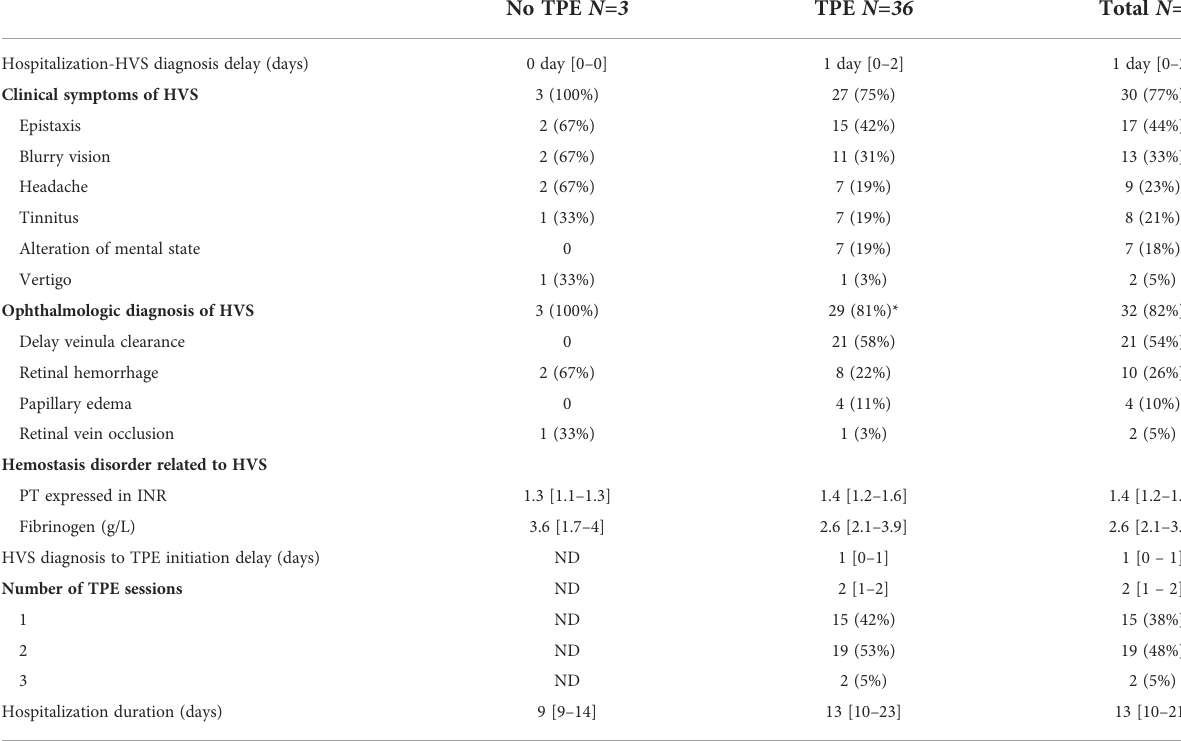
TABLE 2 Description of HVS for